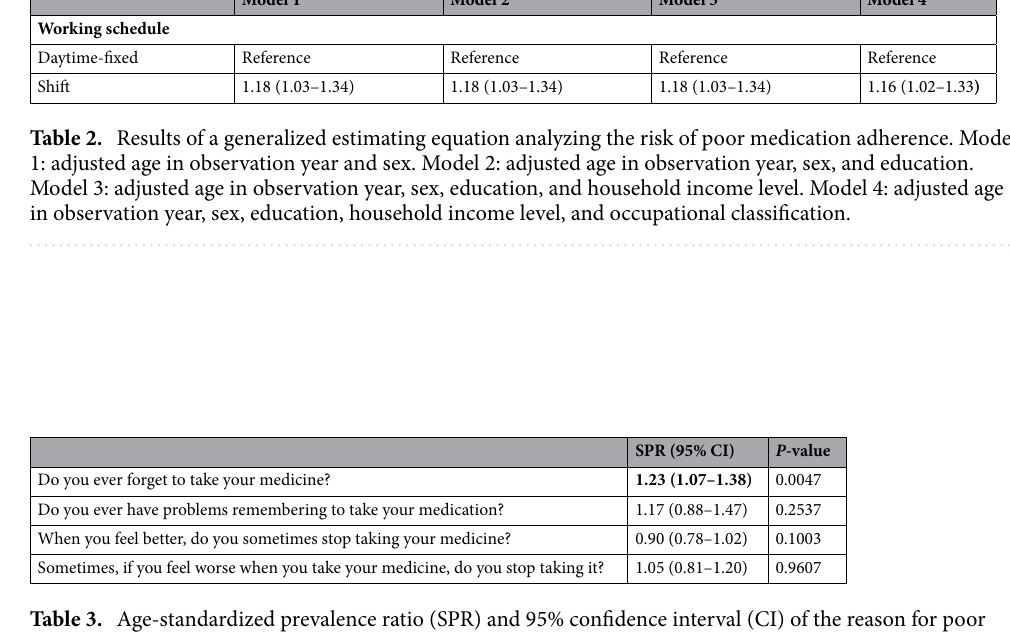
Table 3. Age-standardized prevalence ratio (SPR) and 95% confidence interval (CI) of the reason for poor medication adherence according to each four items of the Morisky Medication Adherence Scale (MMAS-4) among shift workers. *Bold indicates statistical